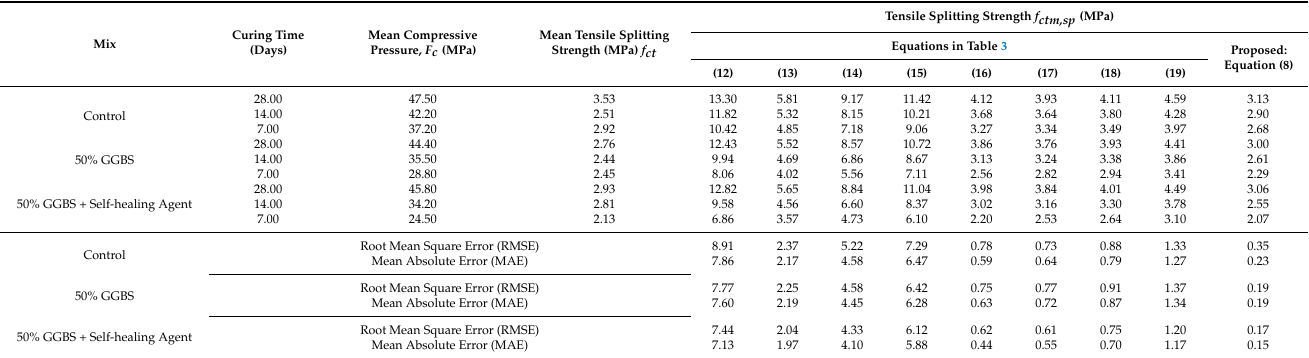
Table 11. Relationship between Compressive strength and tensile splitting